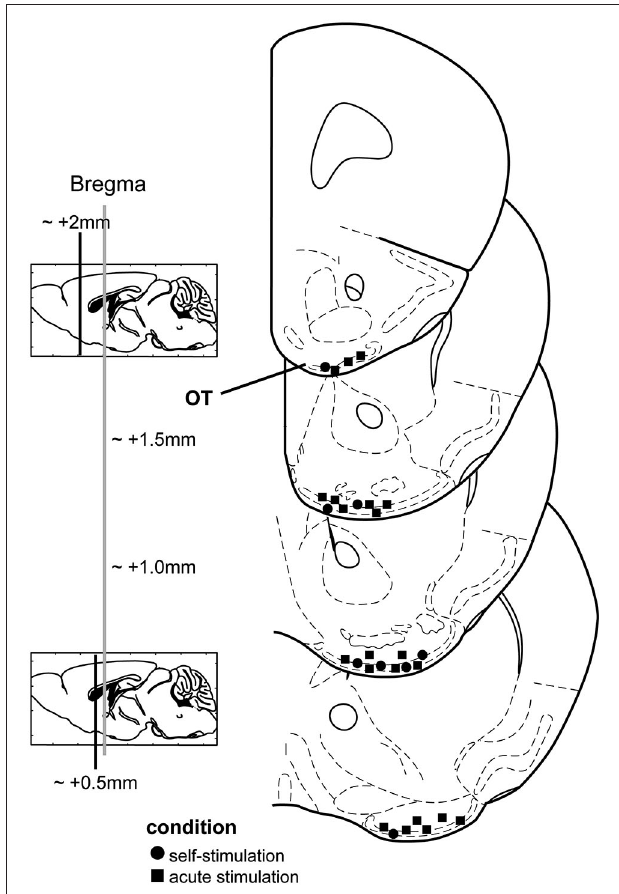
FIGURE 1 | Stimulation electrode locations from both chronic and acute stimulation experiments . Mouse coronal stereotaxic panels displaying the location of stimulating electrode tips in the olfactory tubercle (OT) from mice self-administering stimulation (circles) and those which received acute stimulation (squares). Panels adapted from Paxinos and Franklin